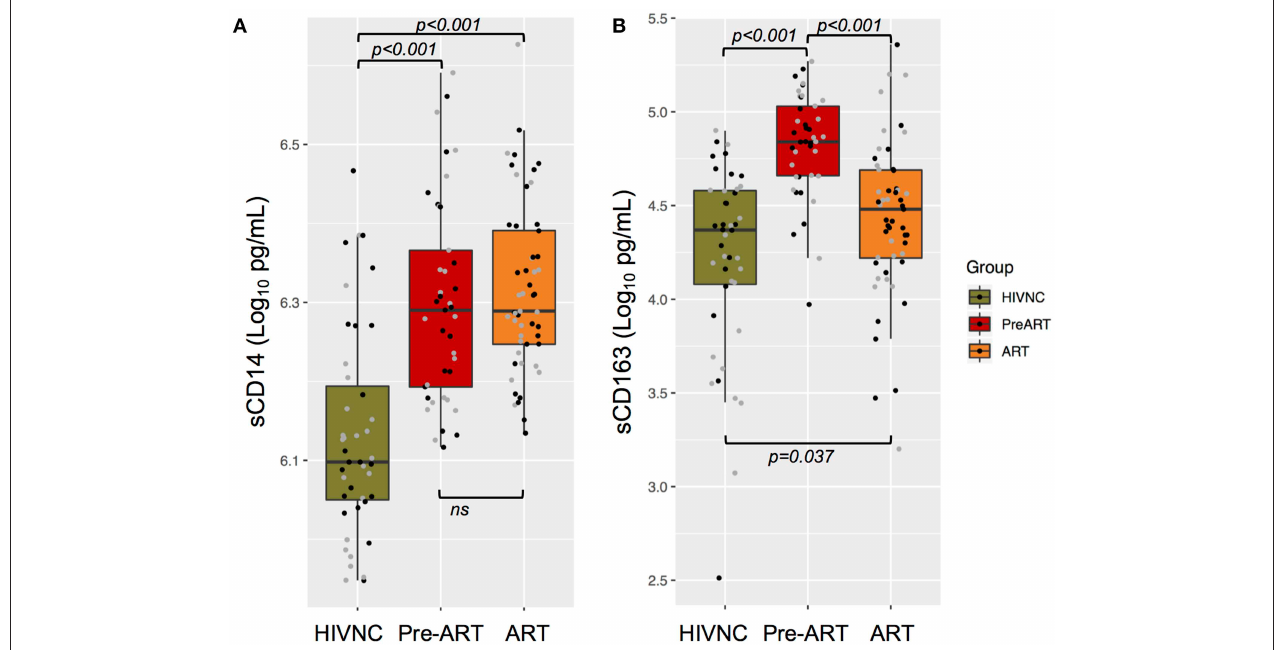
FIGURE 2 | Plasma immune activation markers. Soluble CD14 (A) and CD163 (B) in plasma of the three groups of individuals were measured using ELISA.